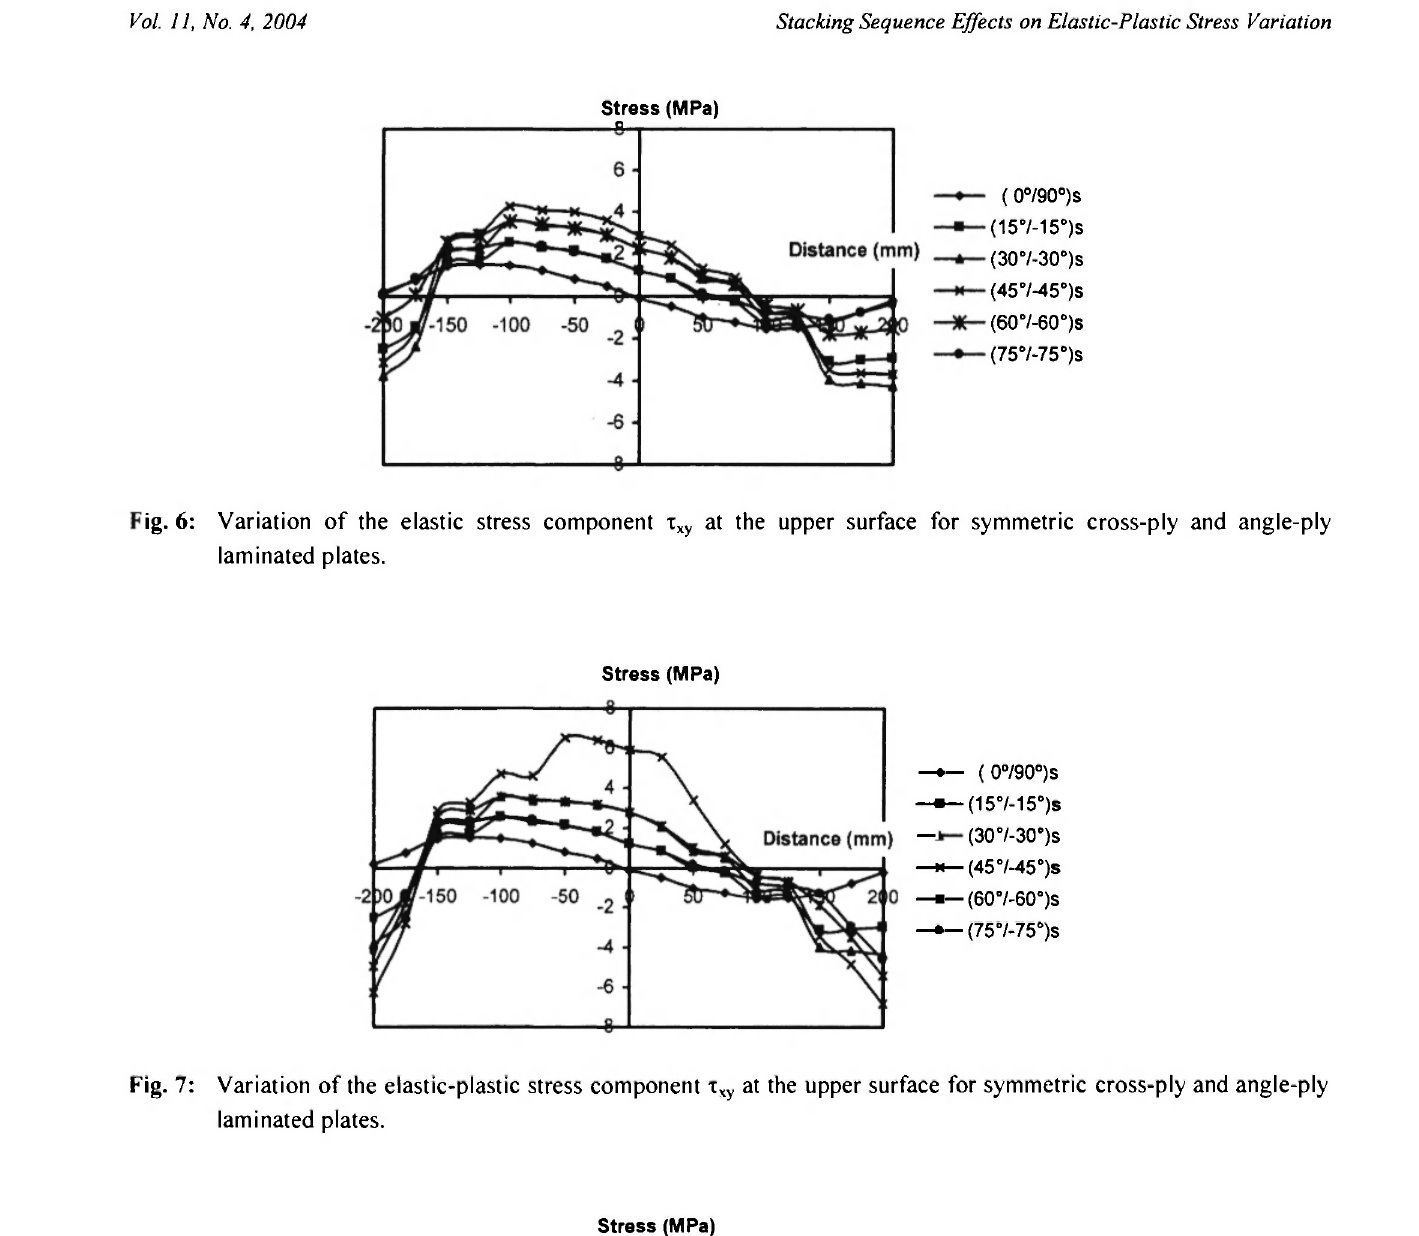
Fig. 7: Variation of the elastic-plastic stress component x xy at the upper surface for symmetric cross-ply and angle-ply laminated plates.